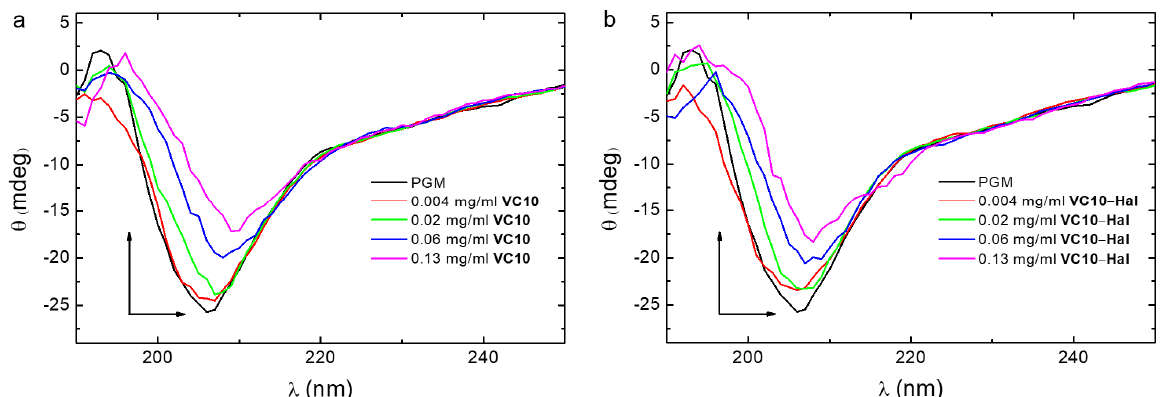
Figure 7. UV circular dichroism spectra of the PGM, PGM– VC10 ( a ) and PGM–[ VC10 – Hal ] ( b ) systems in aqueous solution. The concentration of PGM was constant (1 mg/mL) [ VC10 – Hal ] = 1:1.